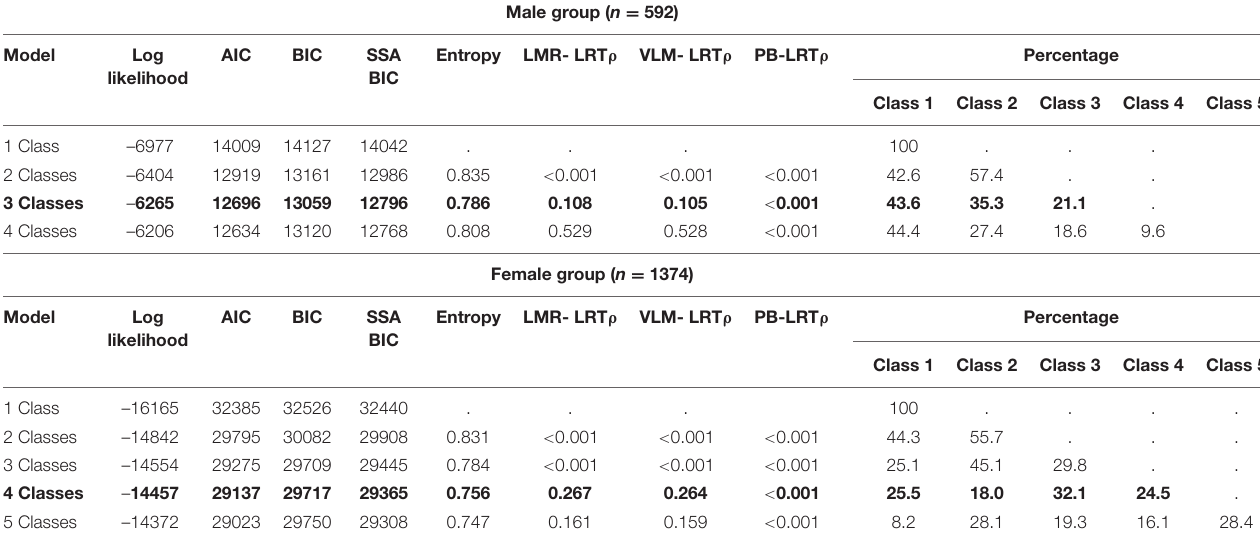
TABLE 4 | Latent class solution model fit indices using the symptoms of depression (PHQ-9) for the male and female groups separately. Male group ( n =